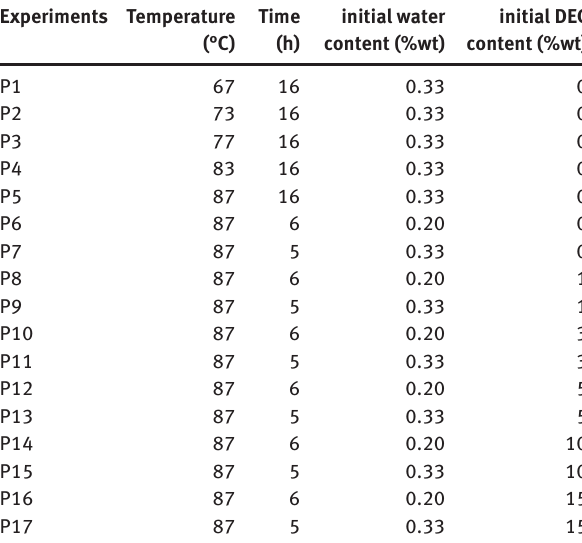
Table 2: Experimental conditions for pervaporation. Experiments Temperature